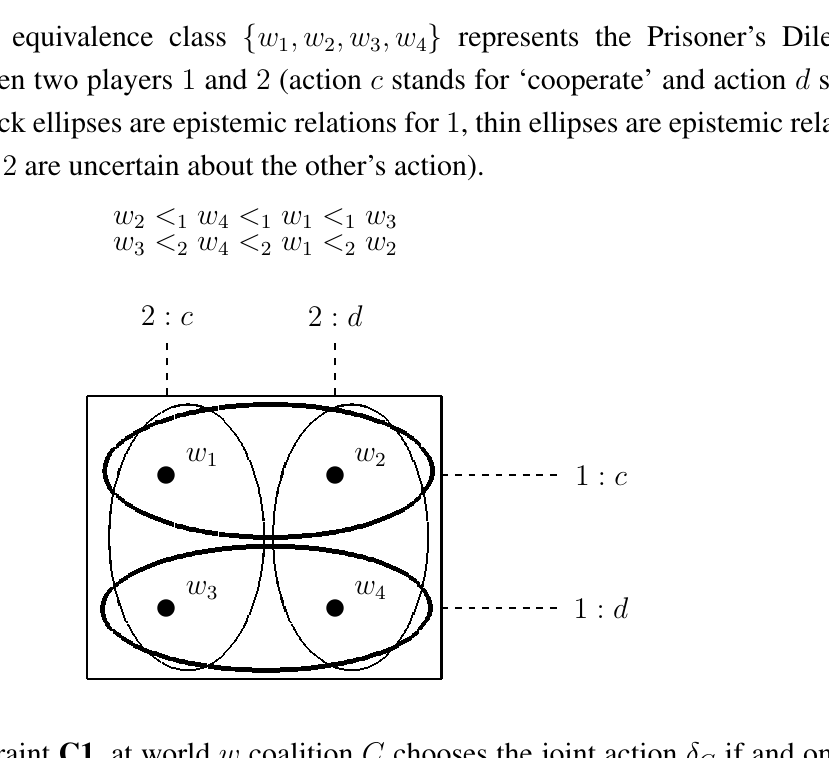
, w , w , w } represents the Prisoner’s Dilemma 1 2 3 4